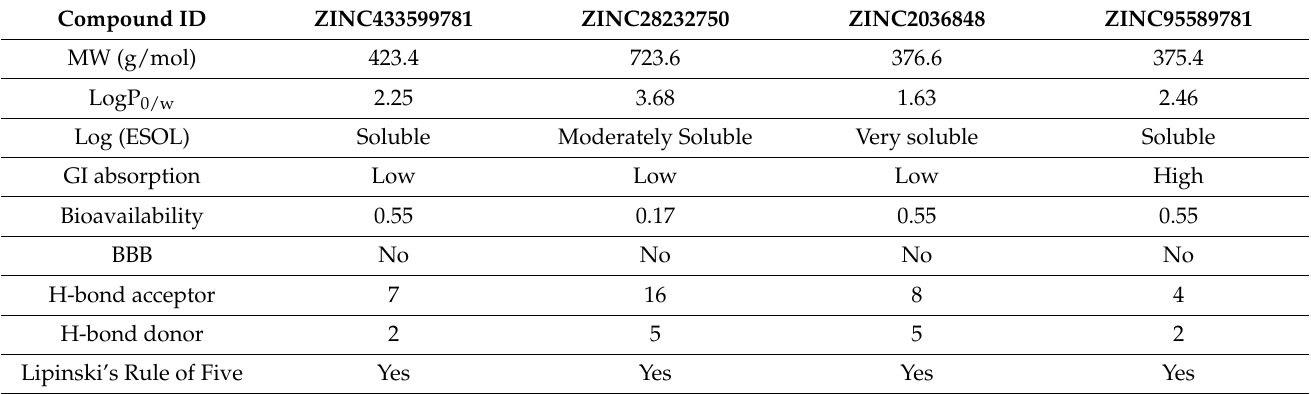
Table 4. ADME analysis of top four hits using Swiss